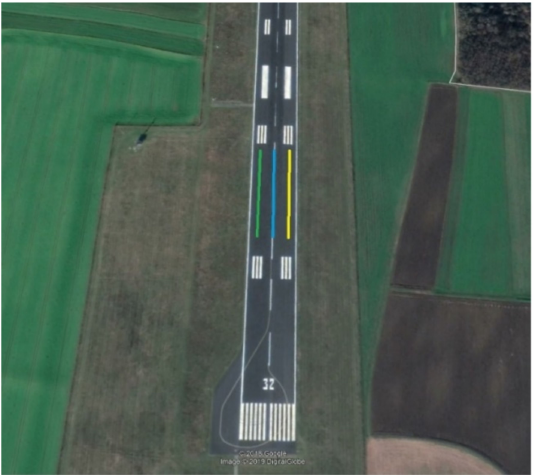
Figure 14. The measurement area: measurements axes—a right axis (green), a middle axis (blue), and a left axis